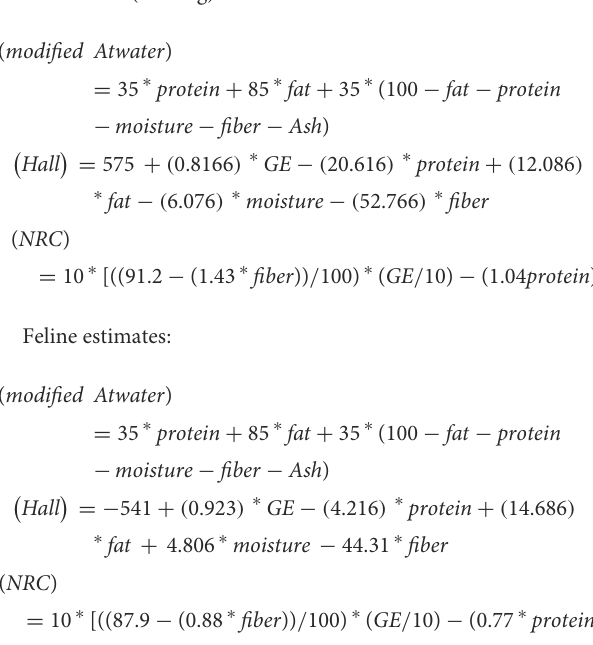
A group of responses ( ∼ 30% of total by random allocation) were assigned as a check group which were not used to establish the new prediction equations. The group of 70% of the responses was used to generate new equations based on species and dietary form (dry or wet). The calculations of variation from measured energy density for all prediction equations were completed to evaluate the accuracy of the energy estimates. The previously established energy prediction statements follow. Gross energy and the estimates are expressed as kilocalories per kilogram. Protein, fat, moisture ash, and crude fiber are expressed as grams/100 grams. Fiber and fat are both the result of the AOAC methods described earlier and are often stated as “crude fat” or “crude fiber.”